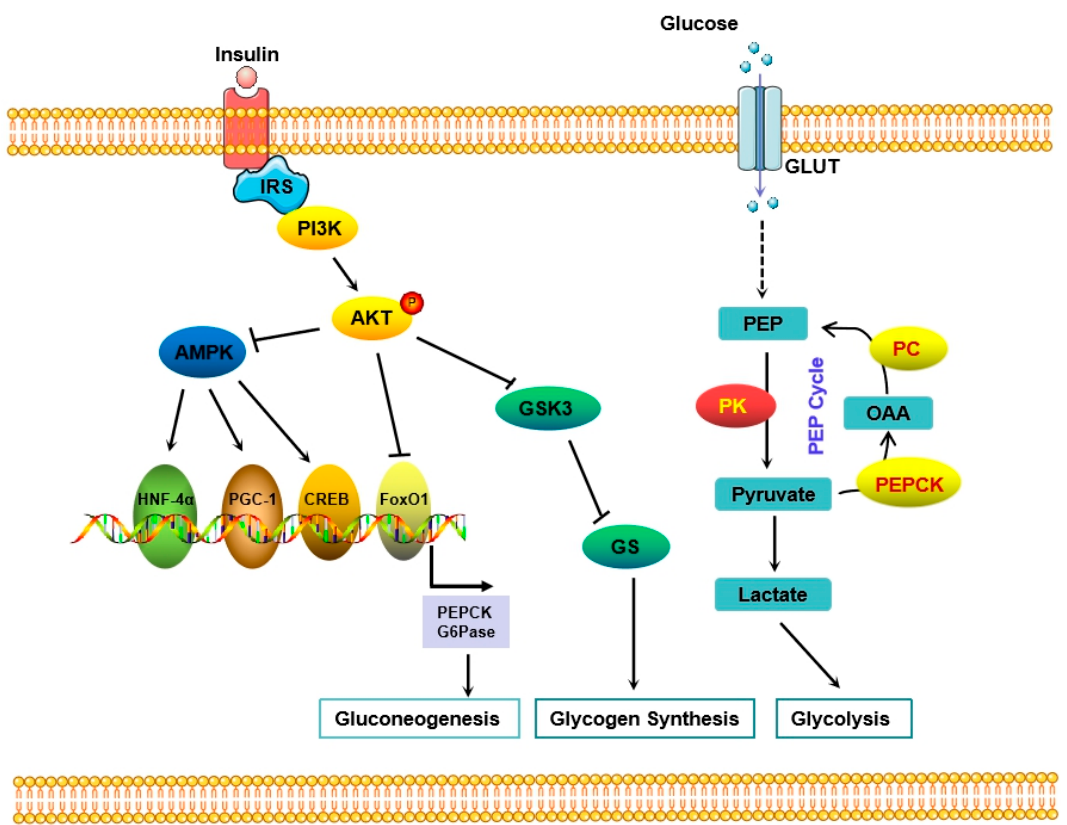
Figure 1. Signaling mechanisms in regulating glucose metabolism.